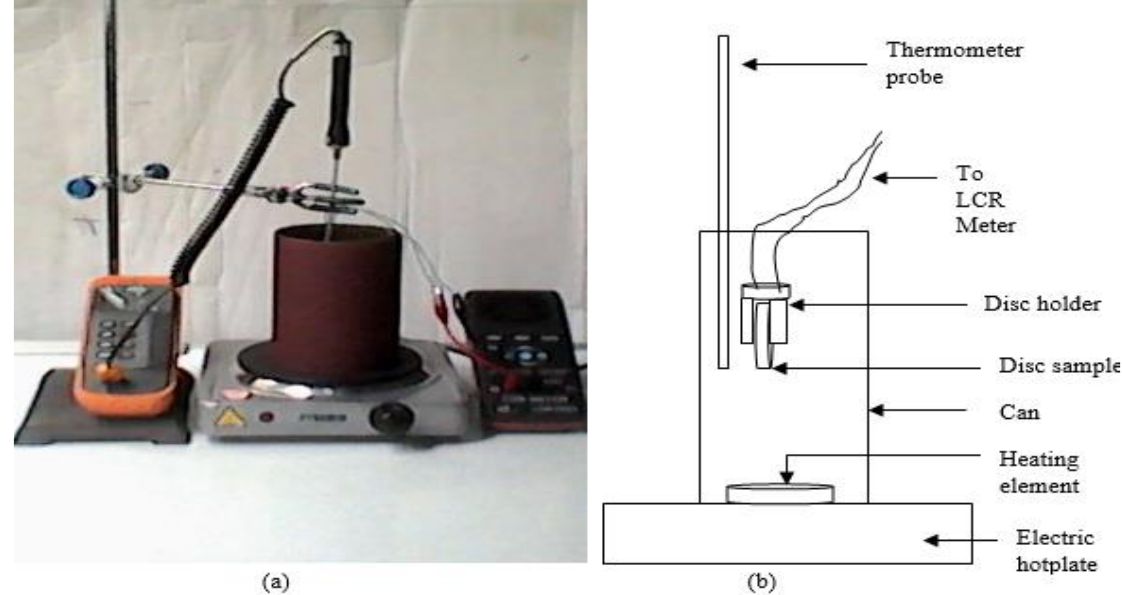
Figure 2. Set-up diagrams: Experimental (a) and Schematic